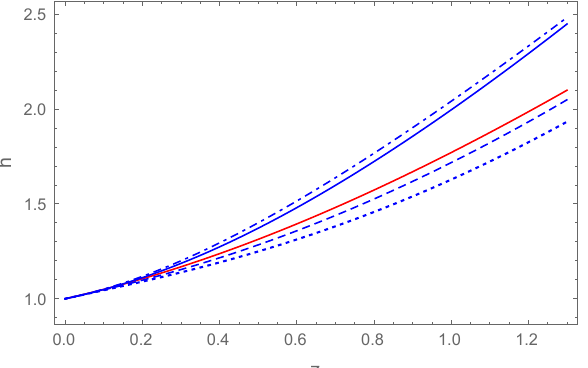
Figure 1. Variation of the dimensionless Hubble function, h , as a function of the redshift z for the tensor K µν = ( β 2 R + γ 2 T ) R µν with different values of the parameters b 2 and g 2 : b 2 = 0.044 and g 2 = − 0.01 (solid curve), b 2 = − 0.0076 and g 2 = 0.001 (dotted curve), b 2 = − 0.013 and g 2 = − 0.0007 (dashed curve), and b 2 = 0.013 and g 2 = 0.03 (dot-dashed curve). The evolution of the Hubble function in the standard Λ CDM model is represented by the red solid curve.